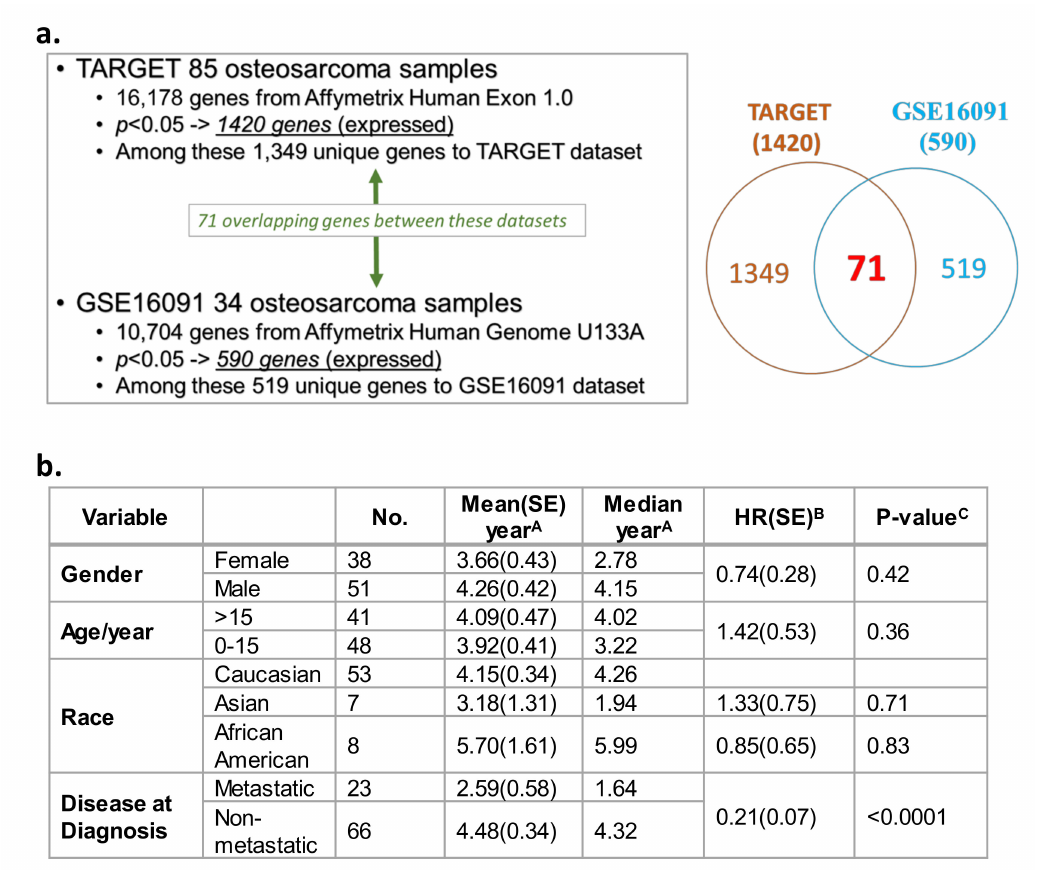
Figure 1. Transcriptome and survival analysis in the two independent overall survival (OS) datasets Therapeutically Applicable Research to Generate E ff ective Treatments (TARGET) and GSE16091. ( a ) Correlation of gene expression profiles, and OS patient overall survival in two independent datasets: TARGET and Gene Expression Omnibus (GEO) GSE16091. ( b ) Survival analysis based on demographic and clinical variables (gender, age, race, and metastasis) present within the TARGET data. Standard error, SE; hazard ratio, HR. A Survival was defined as time in years between diagnosis and death or study endpoint. B HR was calculated by a Cox regression model using the characteristic with a blank HR value as the baseline. C Relationship between a variable and survival was evaluated using a log-rank